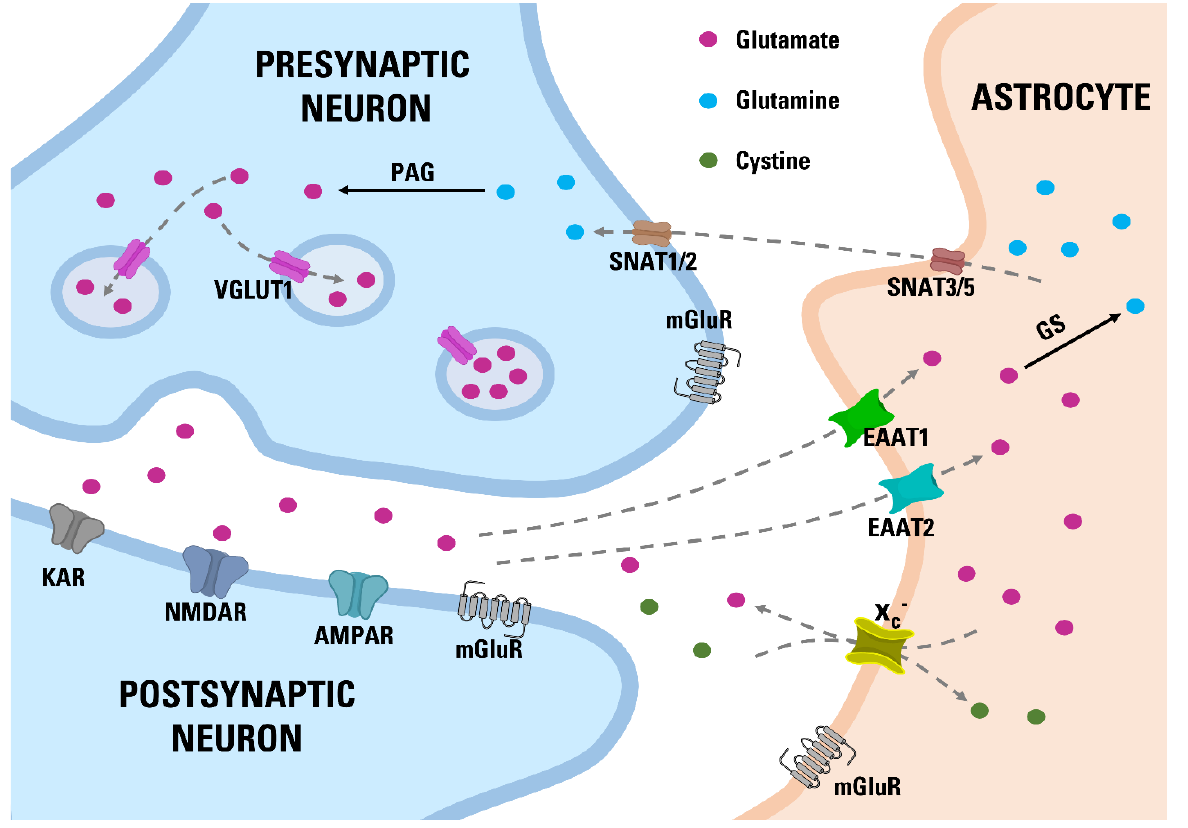
Figure 1. Glu—glutamine cycle in the central nervous system. PAG—phosphate activated glutaminase; GS—glutamine synthetase; KAR—kainate receptor; NMDAR—NMDA receptor; AMPAR—AMPA receptor. Glu released from the presynaptic neuron and that has not been bound to any receptor (NMDAR, AMPAR, KAR, mGluR) is collected by the astrocytic transporters EAAT1 and EAAT2. On the other hand, the antiporter x c − releases Glu from astrocytes to extracellular space while importing cystine. Within the astrocyte, Glu is converted to glutamine by GS and then removed by the SNAT3 and SNAT5 transporters [31]. The released glutamine is taken into neurons by the SNAT3 and SNAT5 transporters, where the PAG converts it back to Glu. VGLUT1 then loads Glu into synaptic vesicles, where it awaits for the next release